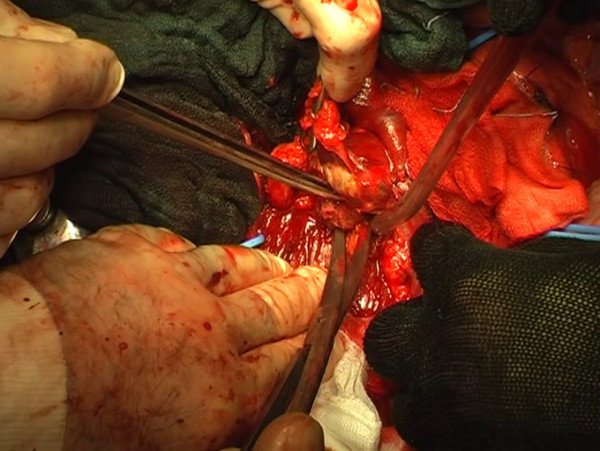
The caval mass is dissected, but it infiltrates the psoas muscle that is partially sectioned with the mass.